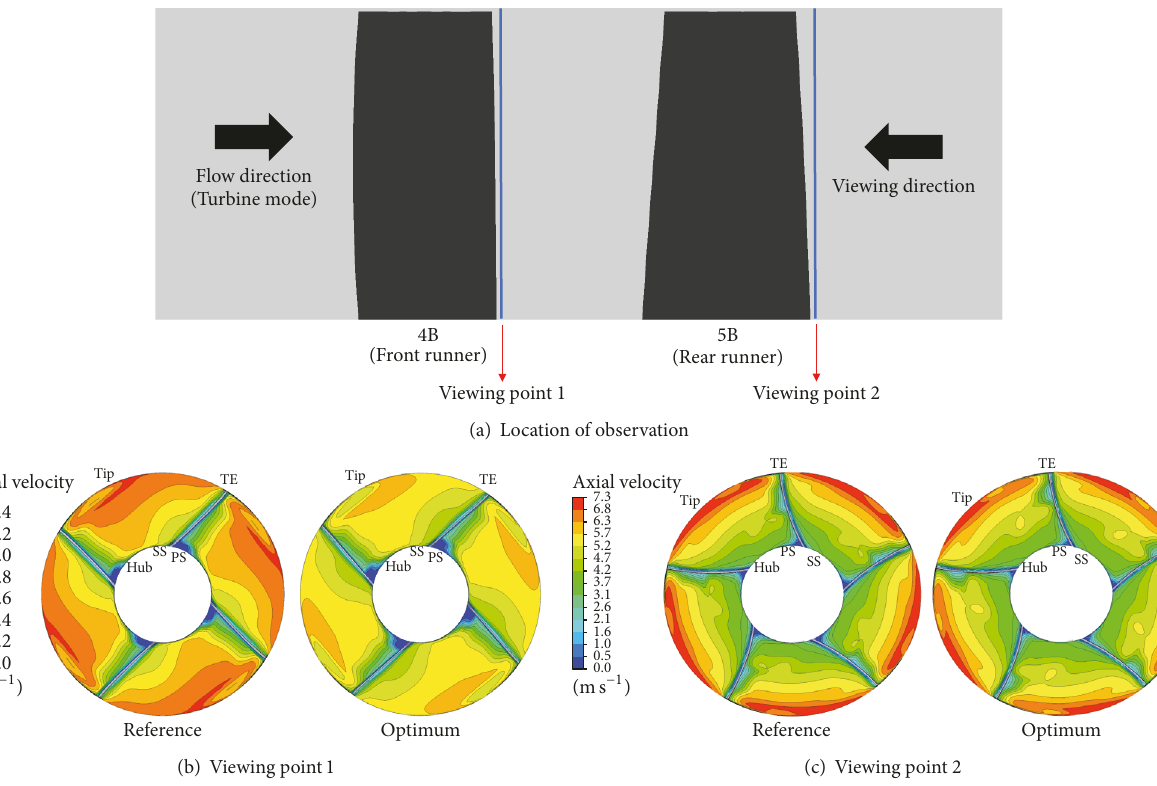
Figure 14: Velocity distributions near the trailing edge of the front and rear runners.